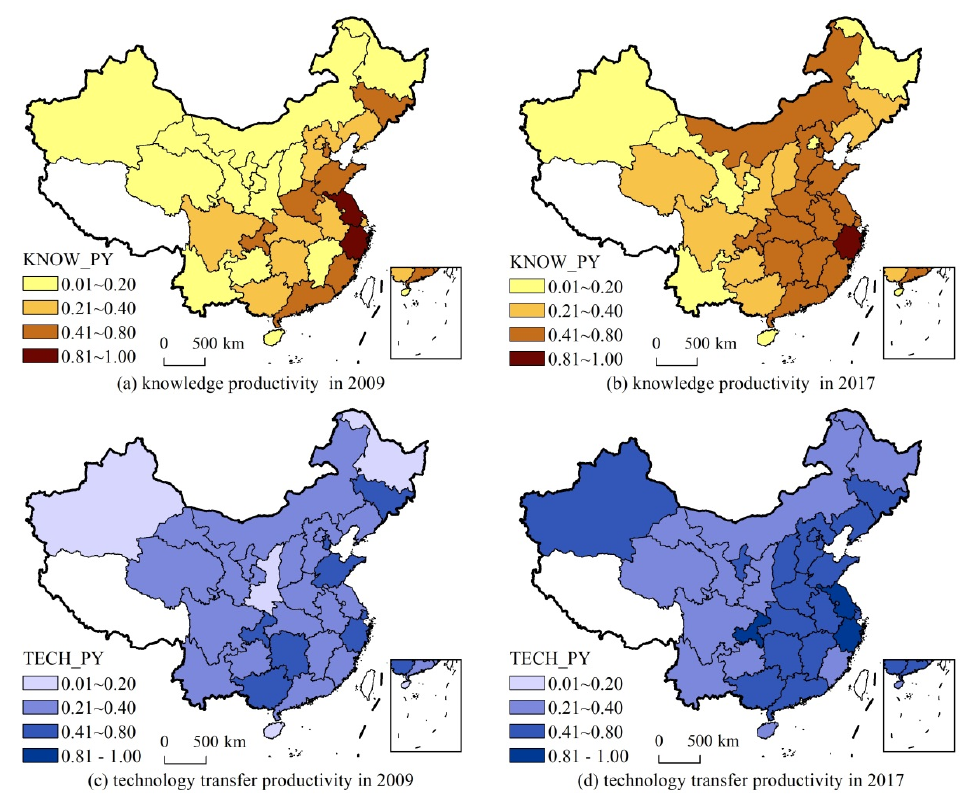
Figure 3. Spatial distributions of knowledge productivity and technology transfer productivity in China.